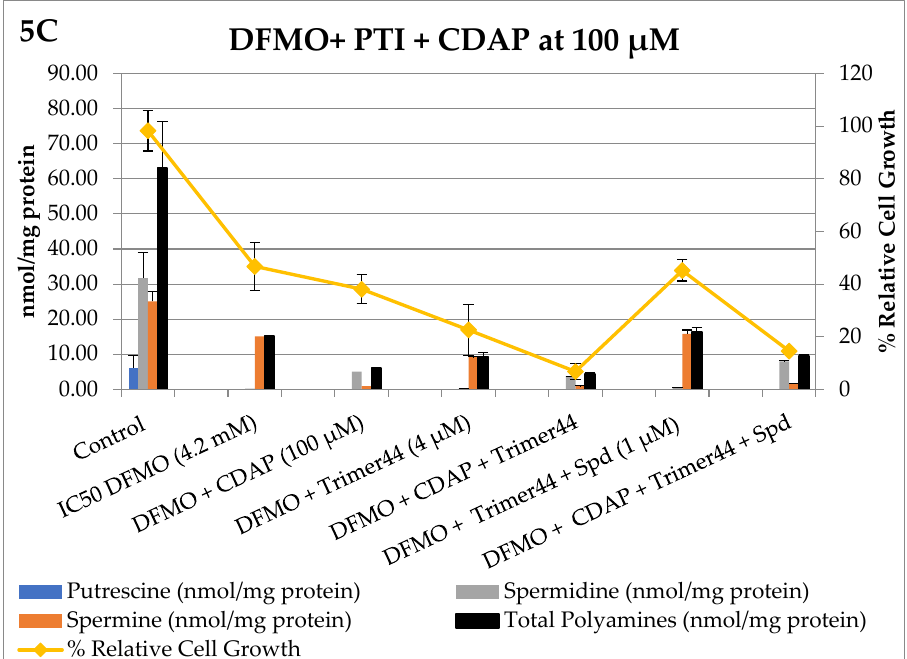
Figure 5. Single and combination therapies in L3.6pl cells with the spermine synthase inhibitor, CDAP. Altered polyamine pools (expressed as nmoles polyamine/mg protein) and L3.6pl relative % cell growth (vs. an untreated control) were observed after 72 h incubation. Controls were run in parallel, polyamine levels were determined in duplicate, and % cell growth in triplicate. The concentrations of compounds were: DFMO (4.2 mM), CDAP (100 µM in Panels A and C and 1 µM in Panel B), trimer44 PTI (4 µM), and spermidine (Spd, 1 µM). Note: in Panel A, we also tested CDAP (100 µM) + Spd (1 µM), which gave 99% relative cell growth and 0.08 ± 0.20, 13.72 ± 0.85, 0.20 ± 0.09, and 14.00 ±0.97 nmol/mg protein for putrescine, spermidine, spermine, and total polyamines, respectively (not shown). This revealed that exogenous spermidine (1 µM) did not further enhance intracellular spermidine levels in the presence of CDAP (100 µM). This observation is consistent with homeostatic control of polyamine levels. In contrast, in the presence of DFMO (4.2 mM), CDAP (100 µM), and exogenous spermidine (1 µM), significant rescue as evidenced by increased cell growth (from 35% to 86%) was observed, which is consistent with the observed increase in intracellular spermidine pools.